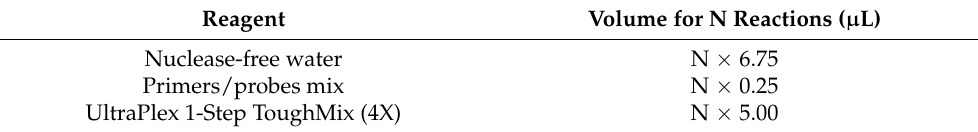
Table 2. Reagents constituting the master reaction mix required for N individual tests.